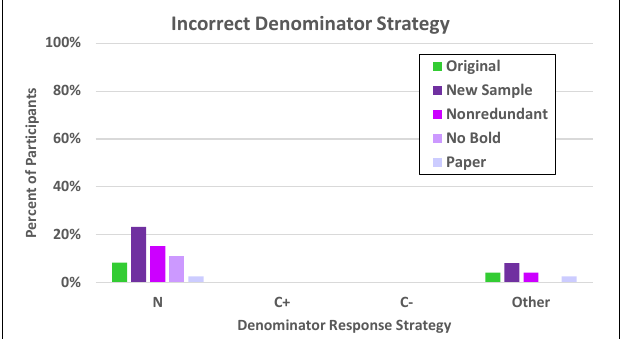
FIGURE 8 | Proportion of participants who consistently used the incorrect denominator strategy on the frequency response format. N denotes the total in the superordinate set (i.e., sample size), C ± denotes the total number of people who have or do not have the condition, other includes both selected and not readily identifiable